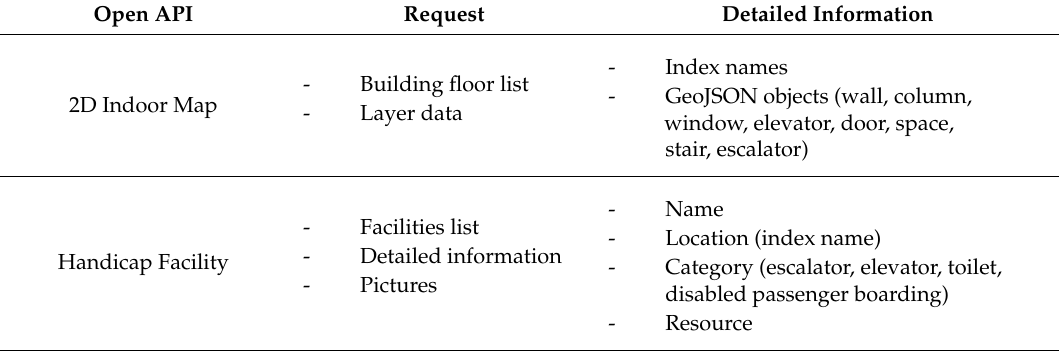
Table 1. List of open application programming interface (API)–related indoor geographic